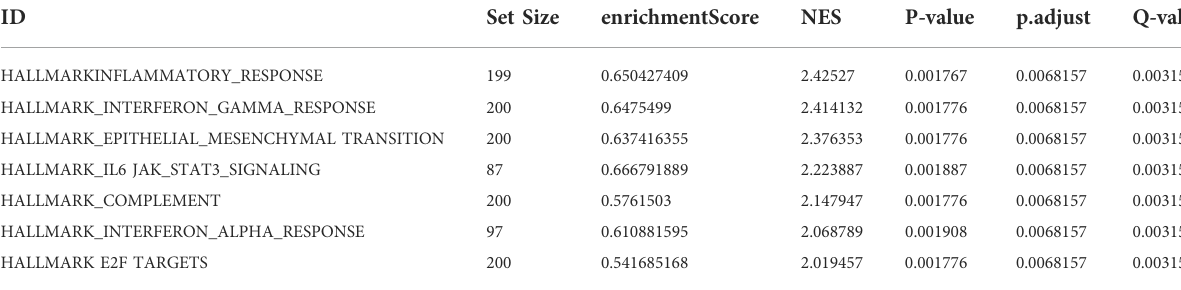
TABLE 3 GSEA summary of HAMP-related gene pathways in ccRCC